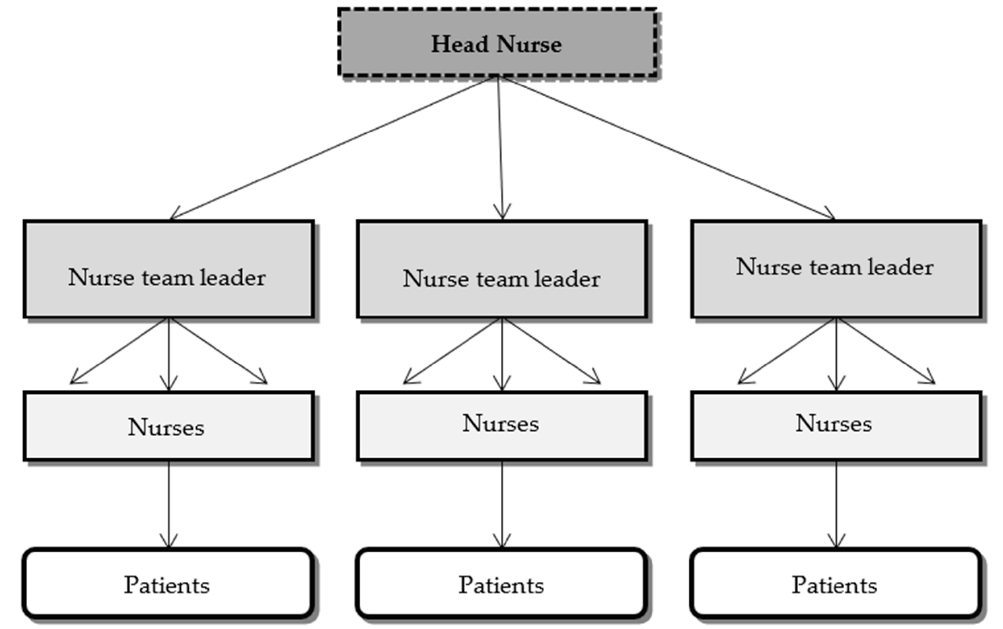
Figure 5. Structure of the team nursing method.